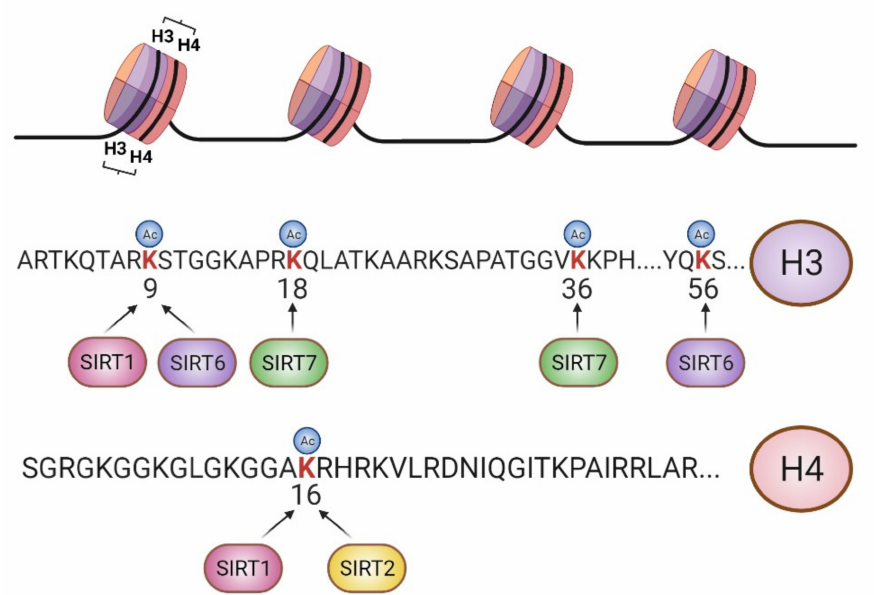
Figure 1. Scheme of major epigenetic targets of sirtuins. Nuclear sirtuins target specific lysine residues of histones H3 and H4 to develop chromatin-associated functions [9]. SIRT1 deacetylates H3K9ac and H4K16ac, and SIRT2 deacetylates H4K16ac during the G2/M transition. SIRT6 deacetylates H3K56ac, H3K18ac and H3K9ac, and SIRT7 deacetylation activity is directed towards H3K18ac and H3K36ac. Figure created with